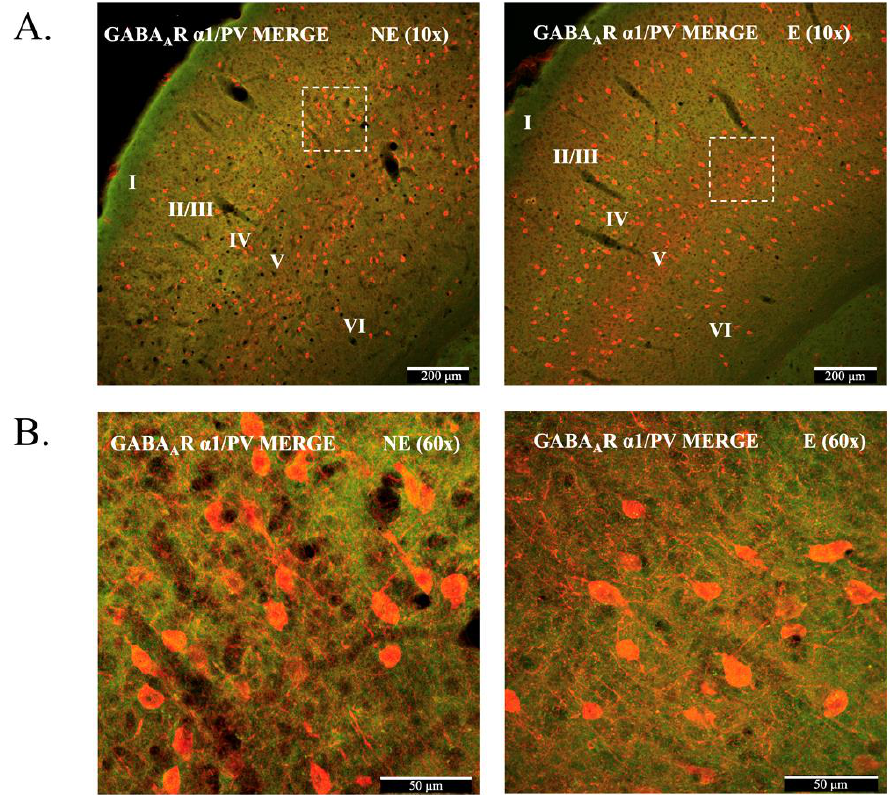
Figure 2. Merged confocal immunofluorescence images demonstrating the co-labelling for GABA A R α1 and PV in the primary SoCx of control (NE) littermate and epileptic (E) stargazer. ( Α ) 10× magnification of GABA A R α1/PV merged image shows co -localization of GABA A R α1 with PV + somas and processes. (Β) 60× (Objective: 60× PlanApo oil) magnification of GABA A R α1/PV merged image clearly shows GABA A R α1 present throughout the cortex as well on PV somas. 2.2. Reduced GABA A R α1 Levels in the Stargazer Primary SoCx with no Change Seen in Other Subunits Expression levels of GABA A R α1 subunit were compared in the stargazer primary SoCx and their control NE littermates using semi-quantitative WB analysis. WB scans revealed bands at the expected molecular weights of ~50 kDa for GABA A R α1 a nd ~42 kDa for β -actin as recognized from the protein ladder (Figure 3A). The band intensities for GABA A R α1 were normalized against β -actin intensities. The results indicated a significant reduction of 18% in the tissue expression levels of GABA A R α1 (NE: 0.960 ± 0.066 [ n = 18], E: 0.78 ± 0.046 [ n = 14], p = 0.041) in the primary SoCx of the stargazers compared to their NE littermates (Figure 3A). GABA A R α3 levels, which have been reported to show a compensatory increase in response to loss of GABA A R α1 [12,46], were not significantly different (NE: 1.000 ± 0.036 [ n = 17], E: 0.935 ± 0.049 [ n = 15], p = 0.519) in stargazers compared to control littermates (Figure 3B).